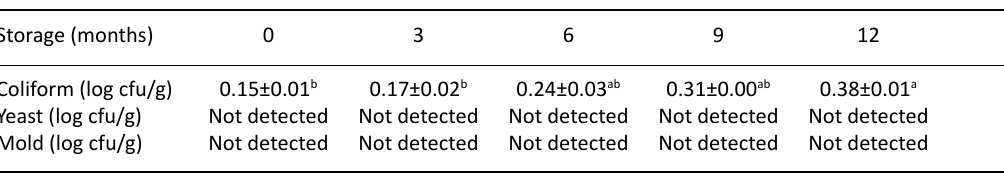
Values are the average of triplicate; numbers in row accompanied by the alike symbols are not varied significantly (α =